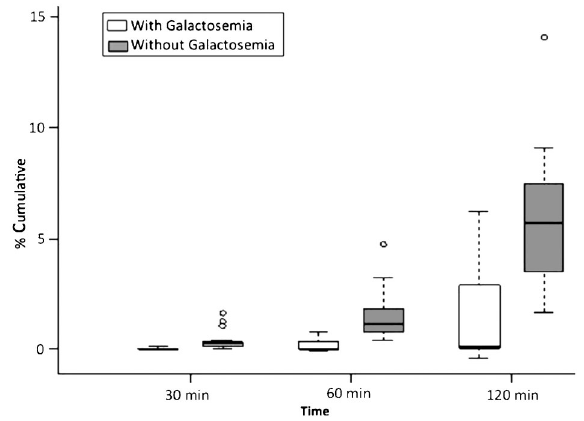
Figure 1. Boxplots of the variables of interest according to group and time: cumulative percent 13 CO 2 from 13 C-labeled galactose. Outliers are indicated by circles.